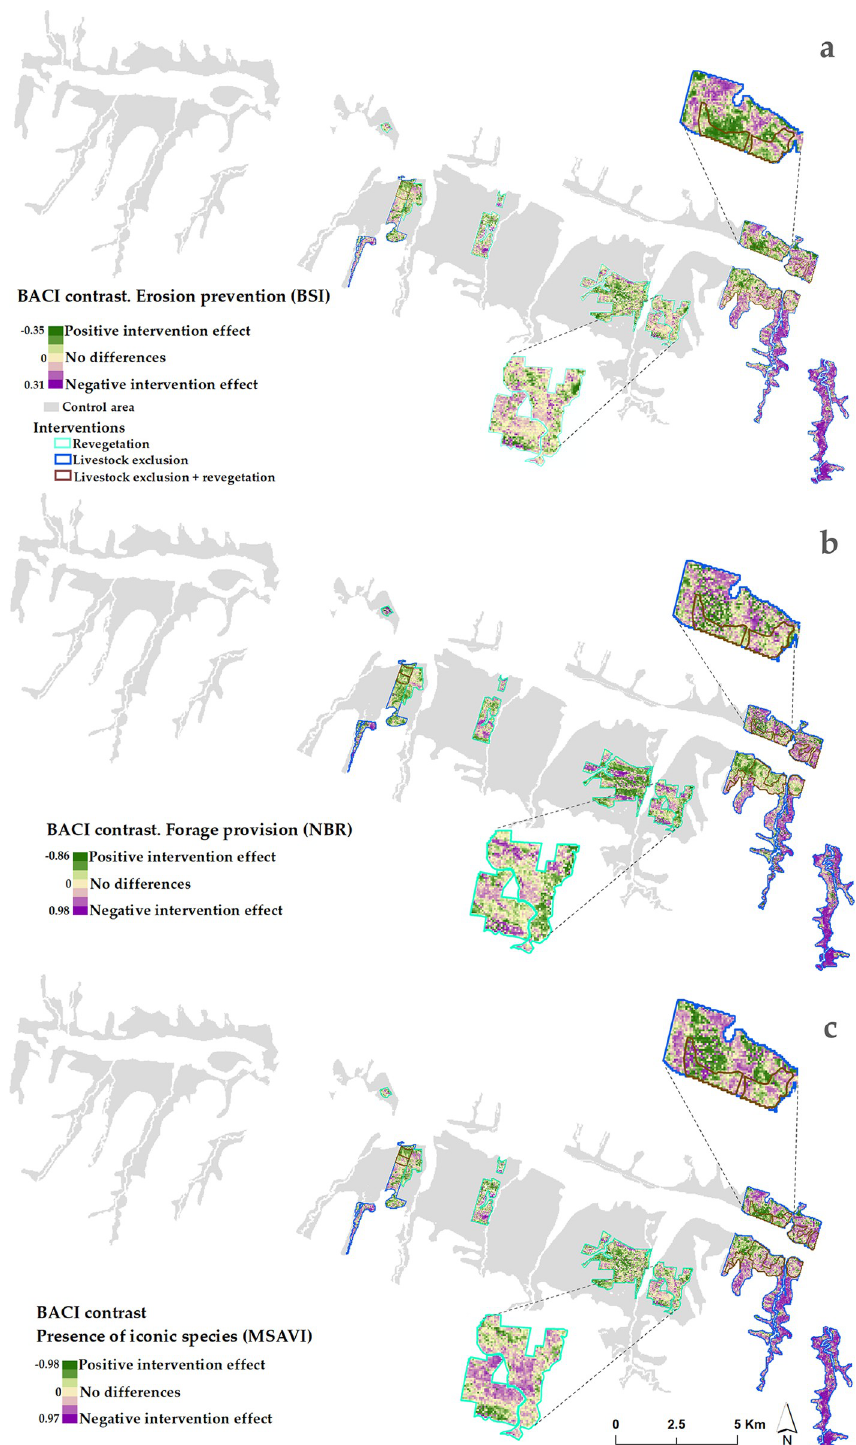
Fig 3. BACI contrast at pixel-level to assess the effect of each restoration intervention in the study area on: a) erosion prevention (based in the BSI index); b) forage provision (based on NBR index); and c) presence of iconic species (based on MSAVI index). The thicket and shrublands area used to for selecting control sites is indicated in grey.